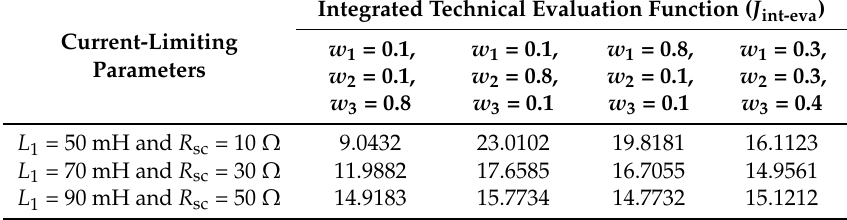
Table 3. Calculation results of the integrated technical evaluation function under different weighting factors (external